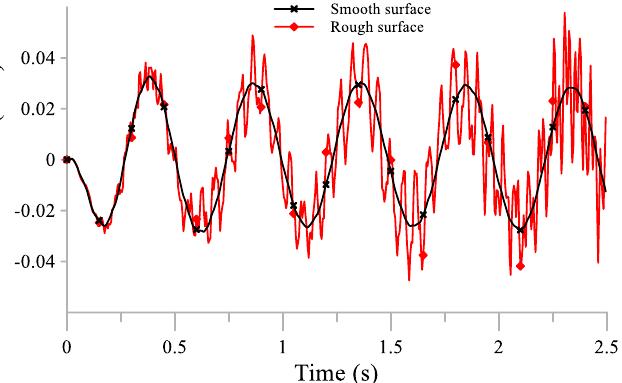
Figure 16. Acceleration response of the damped stationary vehicle on a bridge with rough and smooth surfaces.